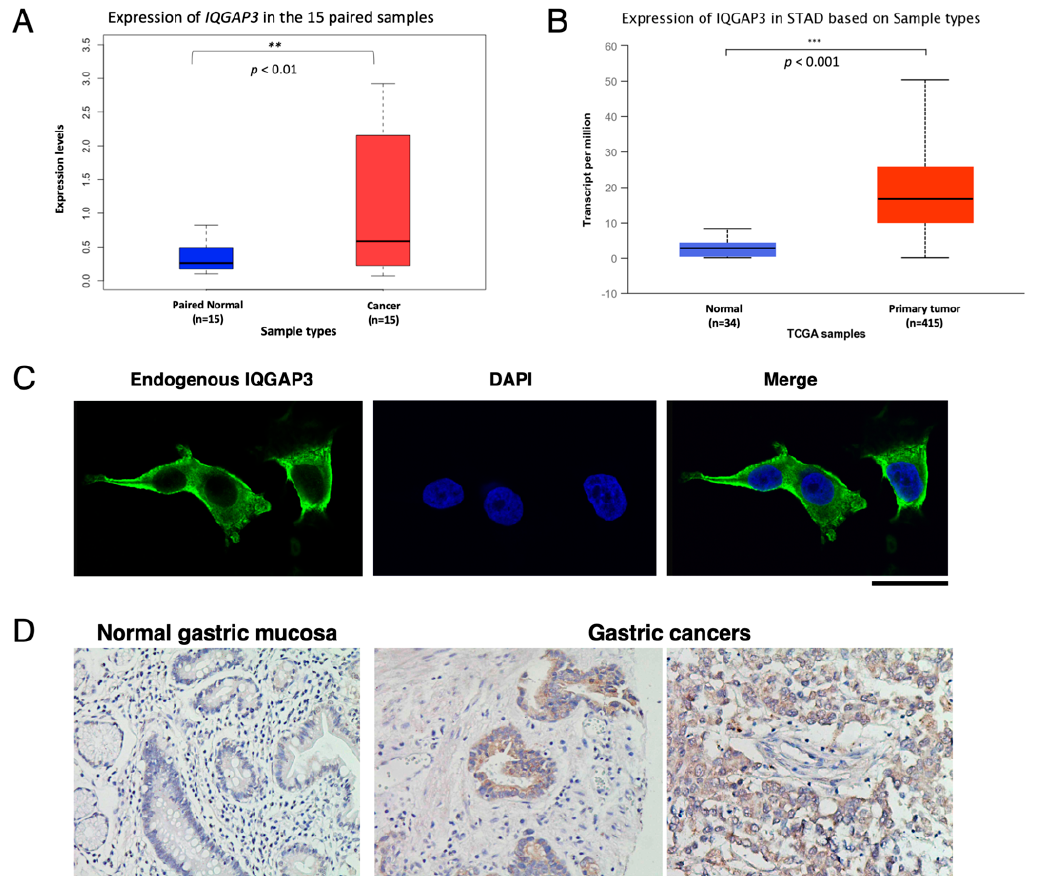
Figure 1. Expression of IQGAP3 gene and protein in gastric cancer. ( A ) Average expression levels of IQGAP3 between the paired 15 gastric cancer and normal tissue samples. ( B ) Average expression of IQGAP3 in patients with primary gastric cancer ( n = 415) comparing to normal controls ( n = 34). The analysis was performed using the TCGA database on UALCAN (http: // ualcan.path.uab.edu / ). STAD: Stomach adenocarcinoma. Blue box: Paired-normal tissues from the 15 patients or the normal gastric tissues from the TCGA database. Red box: Gastric cancer tissues. ( C ) Subcellular localization of endogenous IQGAP3 in MKN1 gastric cancer cells. Magnification; × 1000. Scale bar: 50 mm. ( D ) Representative immunohistochemical staining of IQGAP3 in non-cancerous gastric tissue, intestinal-type gastric cancer tissue and di ff use-type gastric cancer tissue. Magnification; × 200. Scale bar: 50 mm.